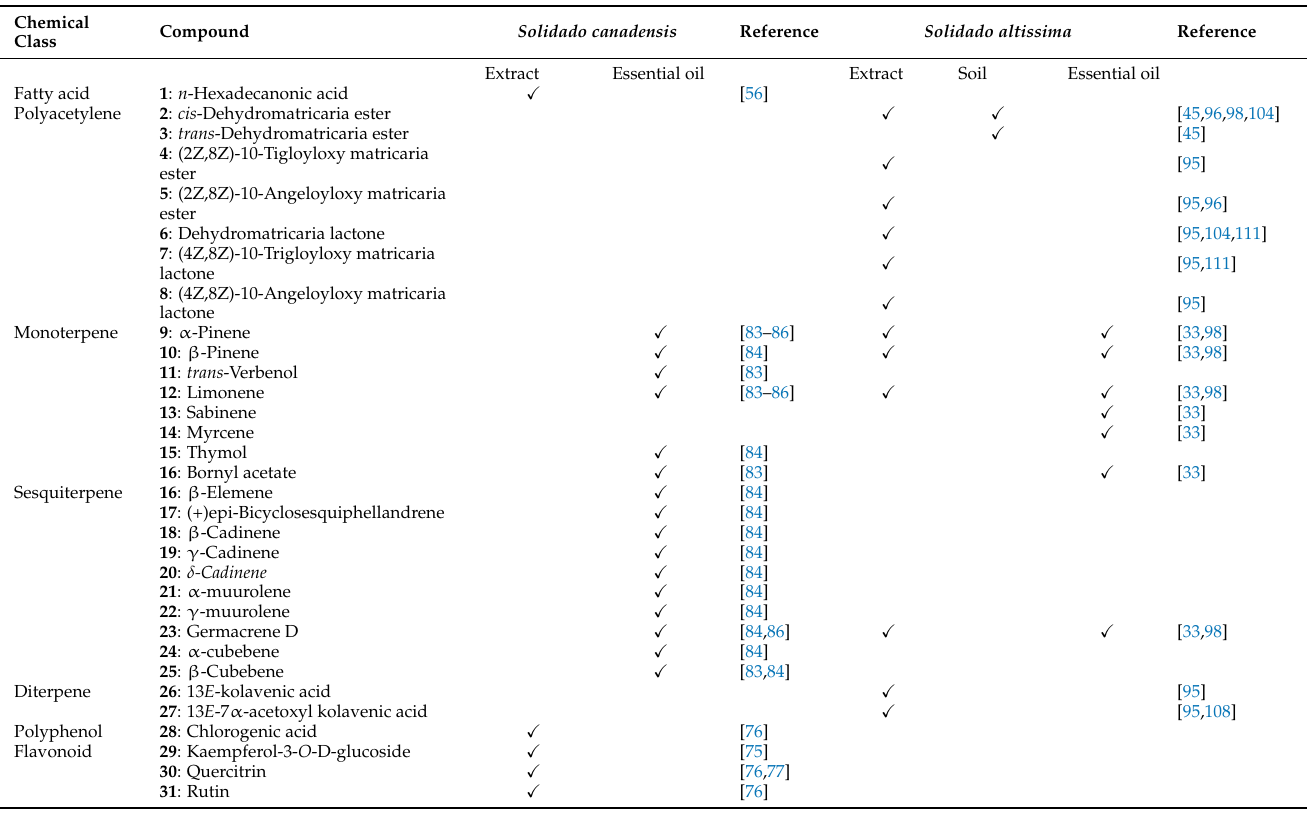
Table 2. Allelochemicals identified in S. canadensis and S. canadensis and their sources. Chemical Class